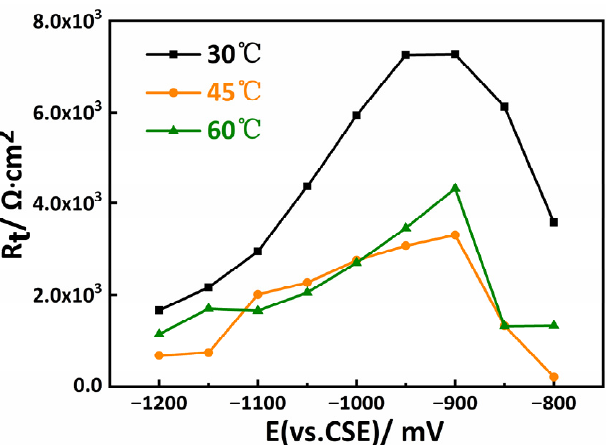
Figure 6. The charge transfer resistance ( R t ) versus potential plots for the X80 steel in the soil medium at 30 °C, 45 °C, and 60 °C.